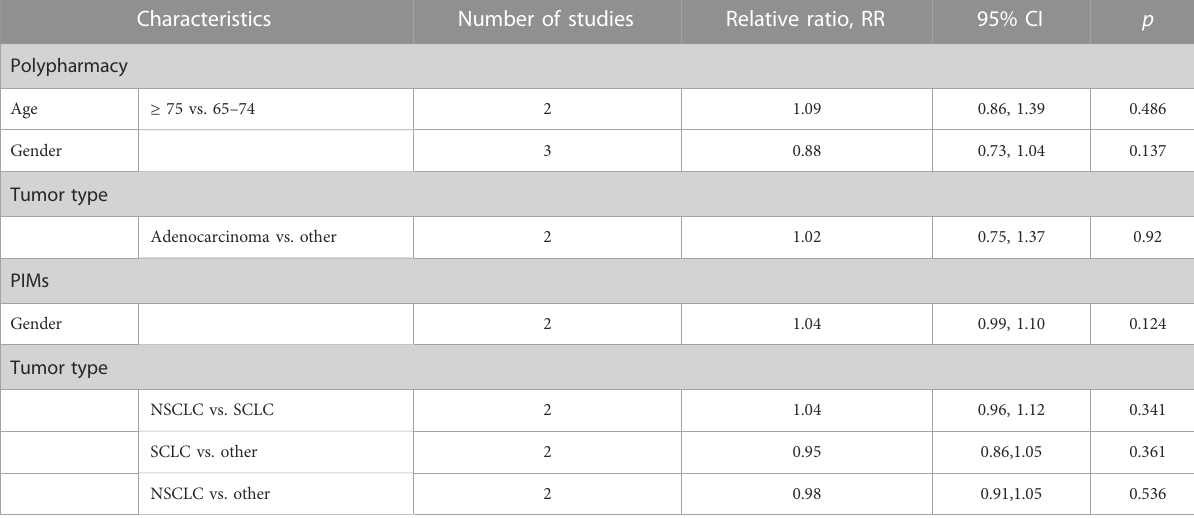
TABLE 2 Factors associated with increased risk of polypharmacy and PIMs. Characteristics Number of studies Relative ratio, RR 95% CI p